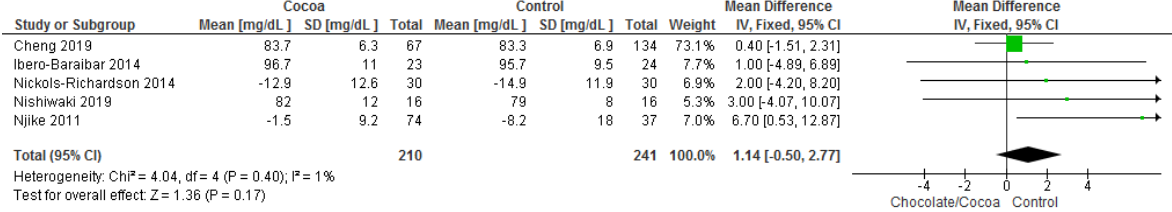
Figure 13. Forest plot of comparison: chocolate versus control, with the outcome—fasting plasma glucose (mg/dL). Nichols-Richardson (2014) and Nijike (2011) reported mean changes and their respective SD, instead of mean scores.